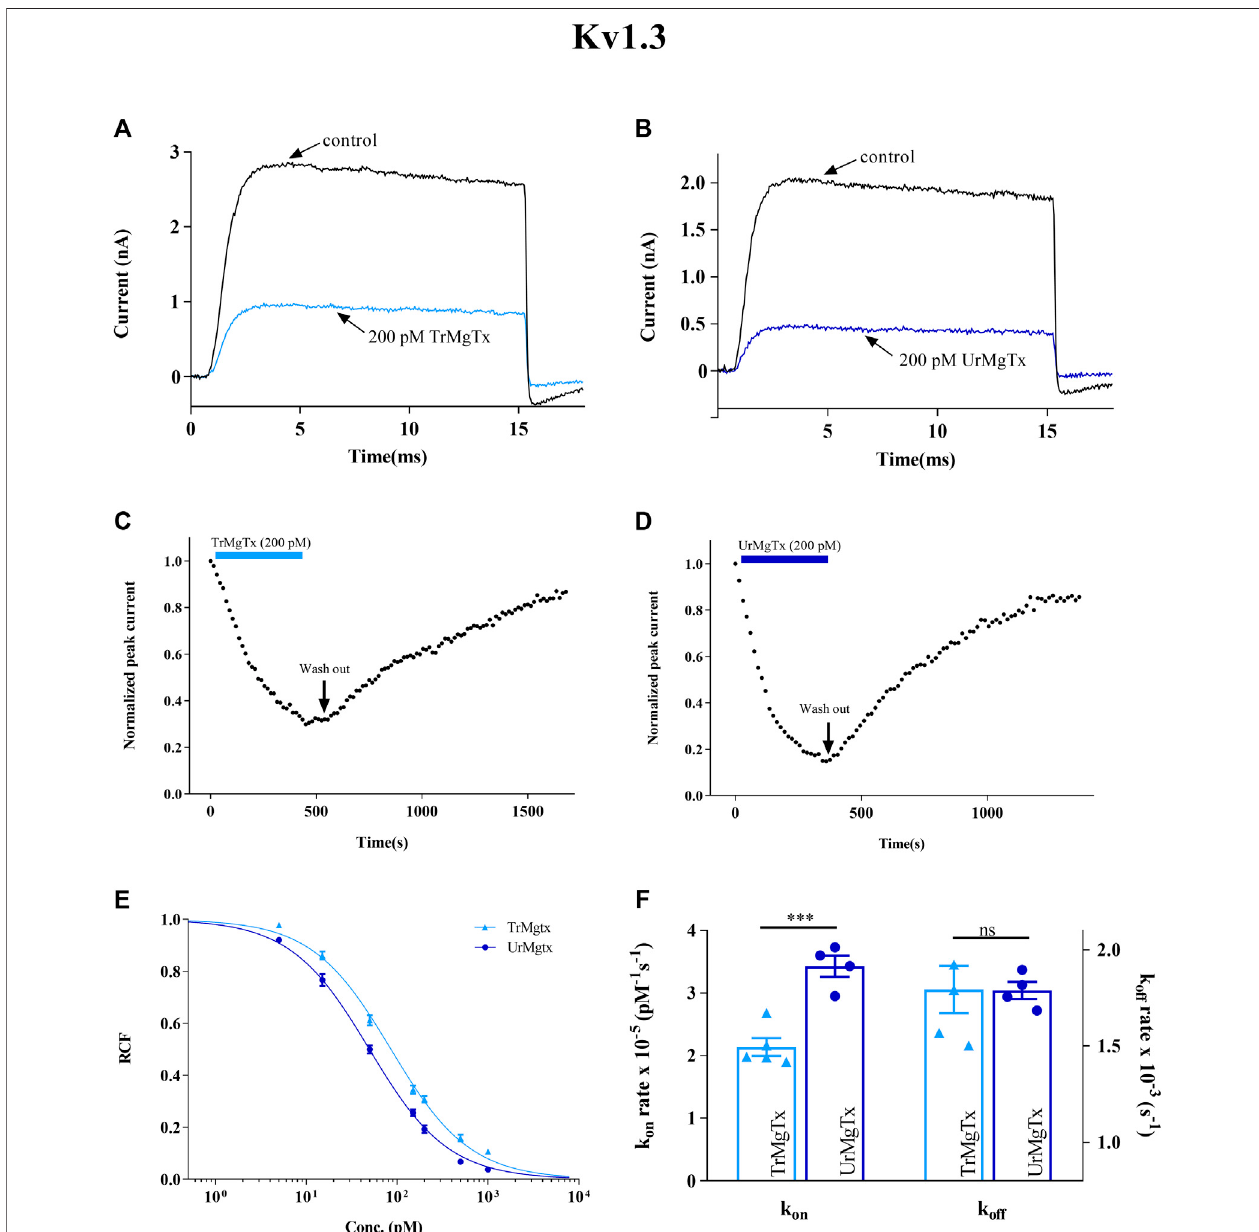
FIGURE 6 | Inhibition of hKv1.3 currents by tagged and untagged recombinant MgTx. (A,B) Whole-cell currents through hKv1.3 were evoked from activated human peripheral lymphocytes by depolarization to +50 mV from a holding potential − 120 mV for 15 ms duration. Test pulses were applied every 15 s. Representative traces show the K + current before the application of toxin (control) and after reaching the equilibrium block in the presence TrMgTx (A) or UrMgTx (B) at 200 pM concentration (as indicated). (C,D) Development of and recovery from the block of hKv1.3 current. Normalized peak currents were measured in whole-cell patch con fi guration and plotted against time as 200 pM of TrMgTx [ (C) , light blue bar] or UrMgTx [ (D) , dark blue bar] was applied to the bath solution. Following block equilibrium, the recording chamber was perfused with toxin-free solution (arrow, washout) to demonstrate reversibility of the block. (E) Concentration-dependent block of hKv1.3 by TrMgTx and UrMgTx. The RCF values taken at different toxin concentrations were fi tted with a three-parameter (inhibition) vs response model (see the Materials and Methods section for details). The best fi t resulted in K d (cid:1) 50 pM for UrMgTx and K d (cid:1) 86 pM for TrMgTx. Error bar represents SEM and n (cid:1) 3 – 4. (F) ComparisonofblockkineticsofTrMgTxandUrMgTxforhKv1.3.Associationrateconstant k on (lefty-axis)anddissociationrateconstant k off (righty-axis)werecalculated from measured time constants ( τ on, τ off ) for the development of the block in the presence of 200 pM toxin and the washout (see panel C , D ), assuming a simple bimolecularreaction betweenthechannelandtoxin(seetheMaterialsandMethods sectionfordetails) andplottedonbar graph.Symbolsindicate individualdatapoints ( n (cid:1) 4); bar heights and error bars indicate mean ± SEM. *** p < 0.001, ns (cid:1) not signi fi cant, unpaired t test.